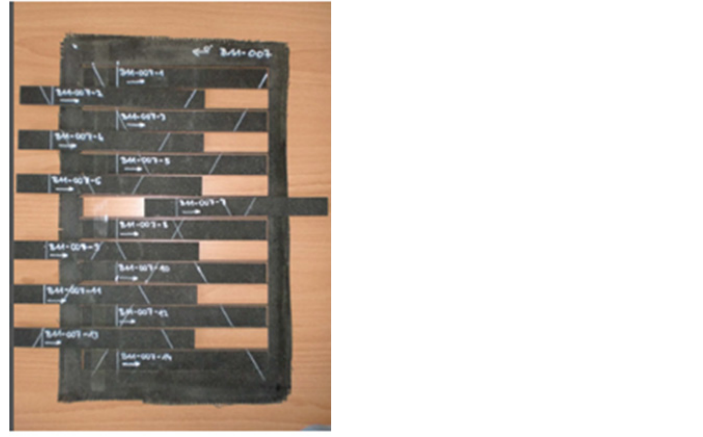
Figure 2: Typical composite plate after cutting using water jet in order to produce tensile test samples.